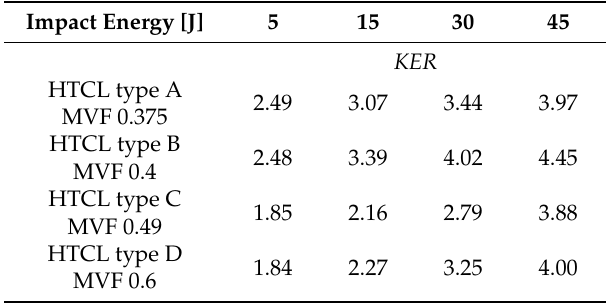
Table 4. The kinetic energy restitutionz ( KER) coe ffi cient of HTCLs with various MVF coe ffi